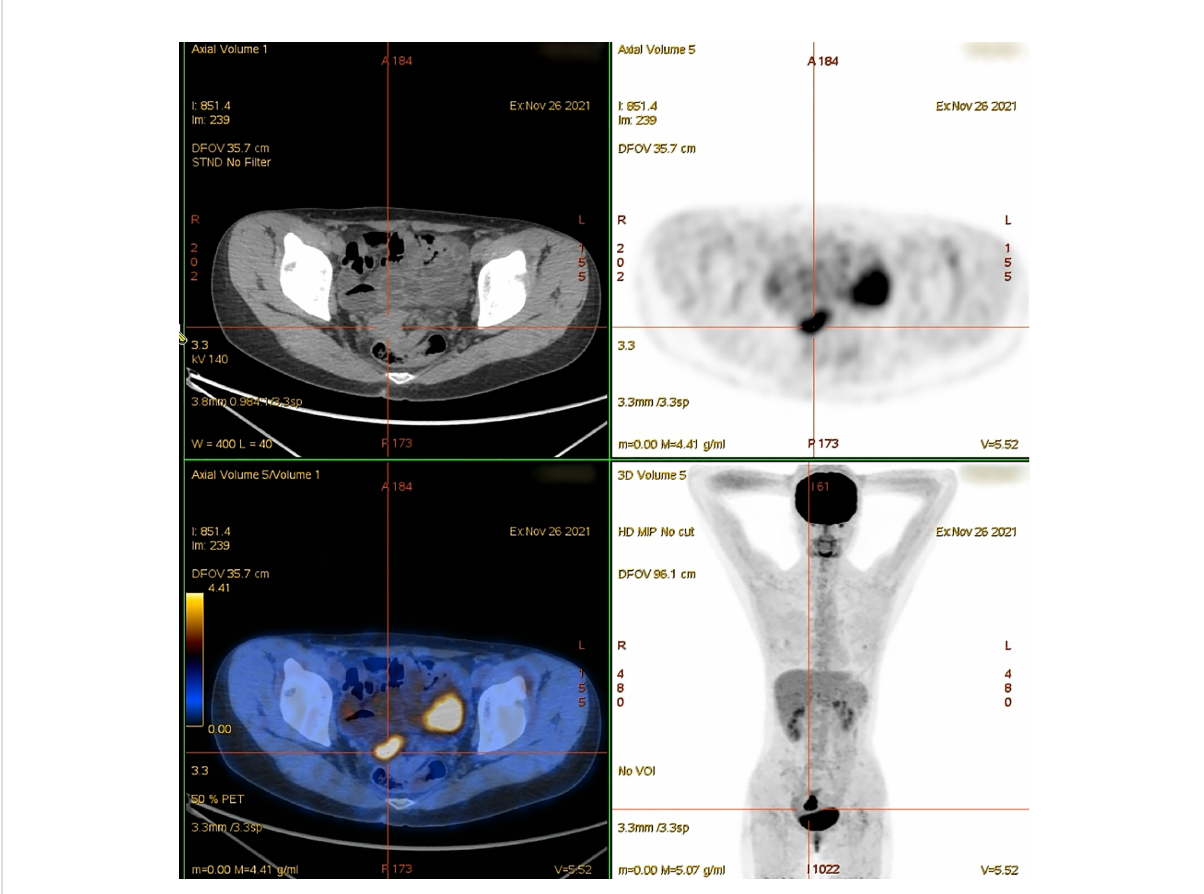
FIGURE 2 Positron emission tomography/computed tomography, showing a mass with fl uorodeoxyglucose (FDG) uptake in the cervix (maximum standardized uptake: